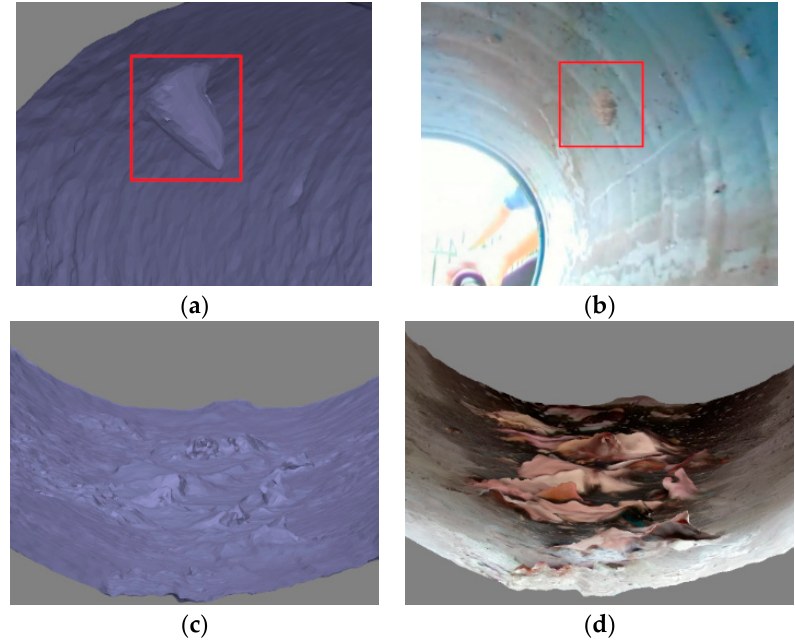
Figure 9. Details of solid model ( a , c ) and corresponding textures ( b , d ).